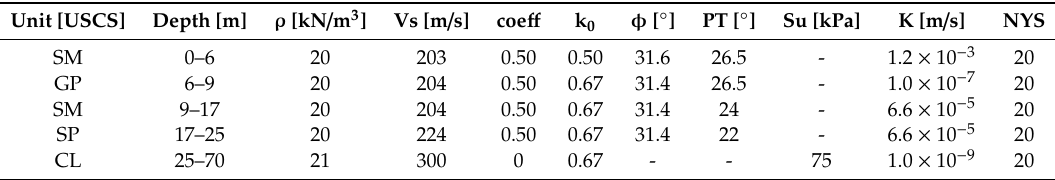
Table 7. Model parameters for the Matanuska